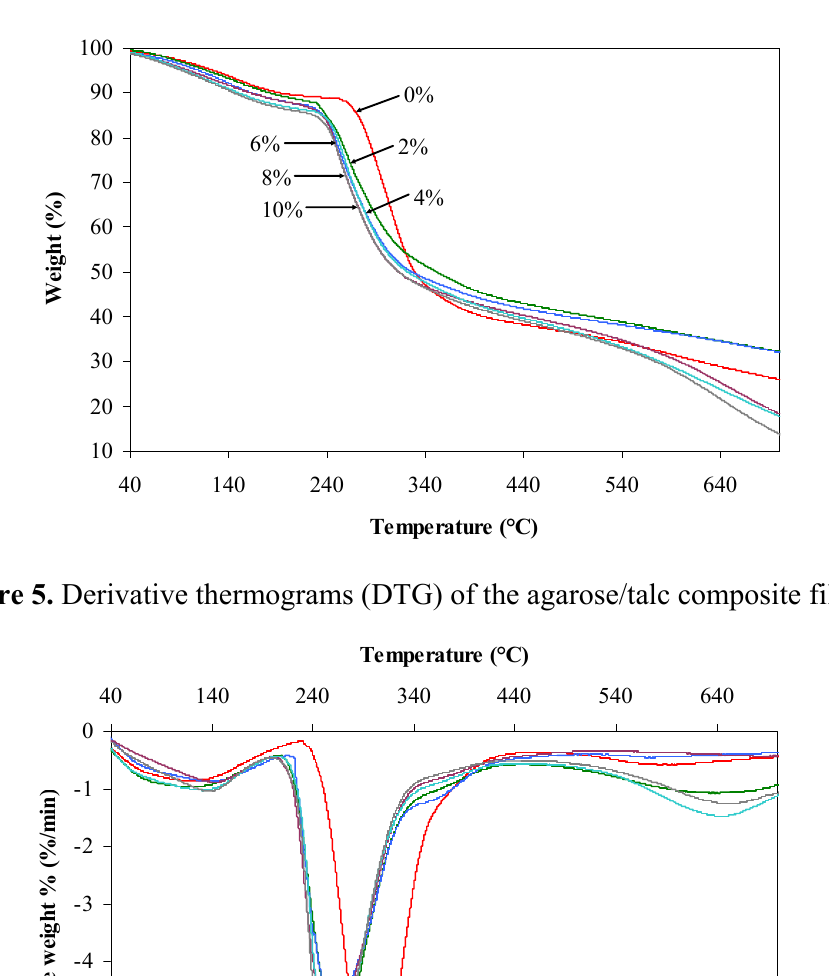
Figure 4. Thermogravimetric analysis (TGA) thermograms of the agarose/talc composite films.